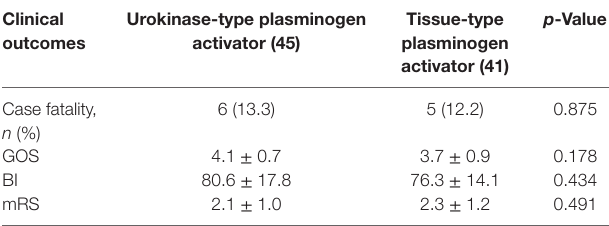
TaBle 3 | Long-term outcomes 1 year after ictus. clinical